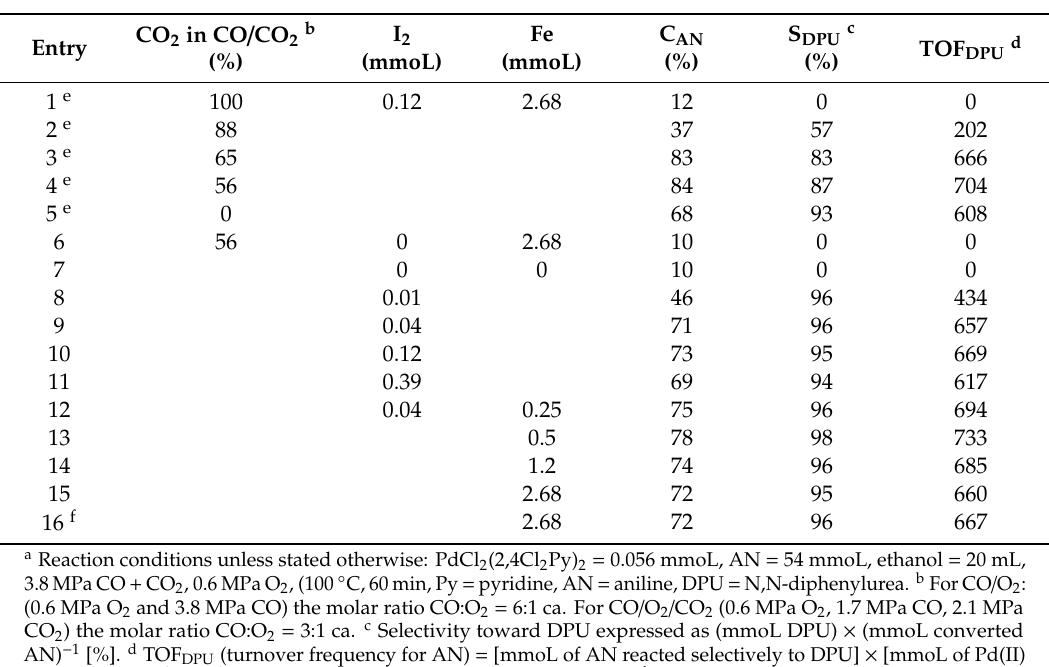
Table 1. Parameters obtained for the carbonylation a of aniline with CO / CO 2 / O 2 mixture, catalyzed by Pd(II) complexes: conversion (C AN ), selectivity (S DPU ) and turnover frequency (TOF DPU ) of the catalyst, depending on the contents of CO 2 in CO 2 / CO, iodine, and iron.